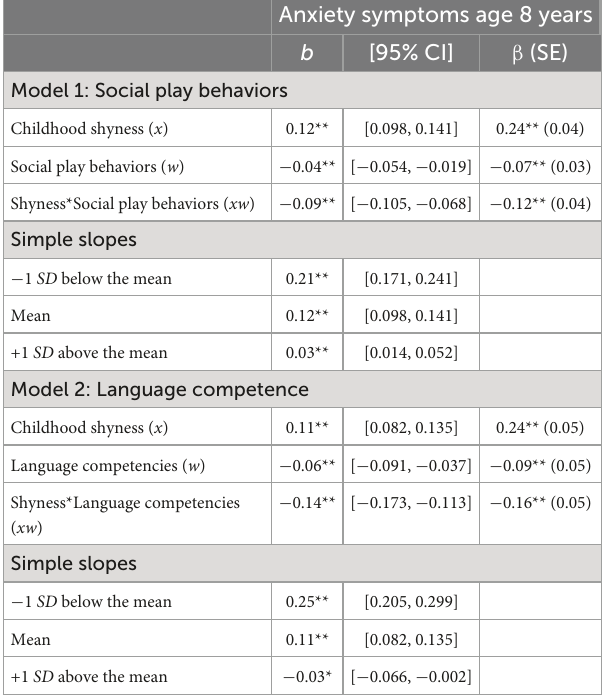
TABLE 3 Results from interaction analyses including tests of simple slopes of interaction of the moderators social play behaviors and language competencies with 95% confidence